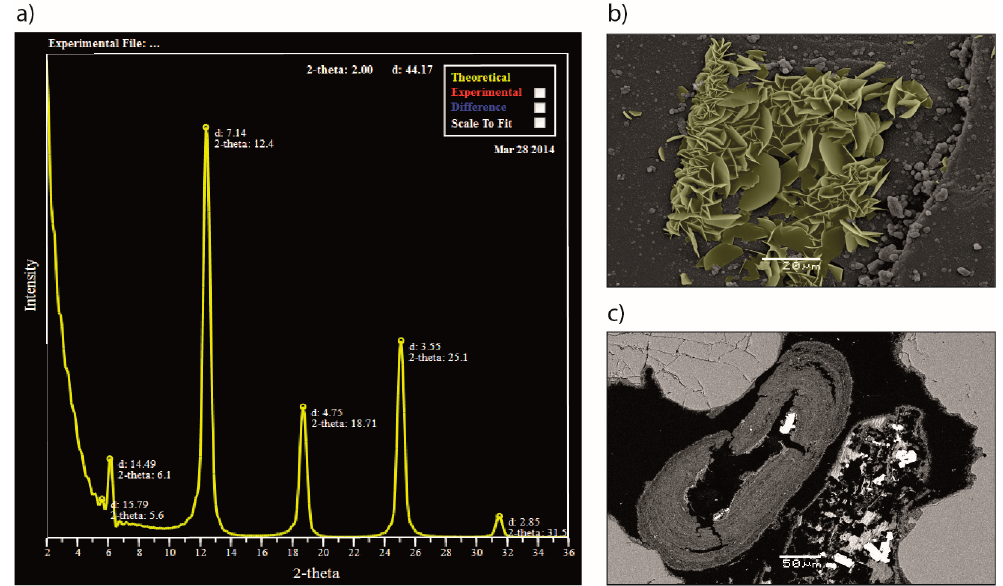
Figure 3. Chlorite solid solutions and occurrence: ( a ) Modelled X-ray diffraction pattern by use of Newmod II, showing a fit with typical chlorites found in a potential CO 2 reservoir in the North Sea; the Johansen Formation. The best fit was found for a Fe2.34 chamosite, with a Fe/(Fe+Mg) ratio of 0.93; ( b ) Scanning electron microscope image of grain coating chlorite from laboratory experiments of daphnite growth (yellow colour applied for reference). Individual crystals are half disk-shaped, growing perpendicular to the host grain surface, ranging in size from 2–15 µm; ( c ) Scanning electron microscope image of ooidal chlorite. Crystal growth occurs in dense, concentric layers around a nucleus grain, which has been dissolved in this case. Grain coating chlorite covers the surface of framework quartz grains. Ghost rims of chlorite coats remain where the framework grain has been dissolved.